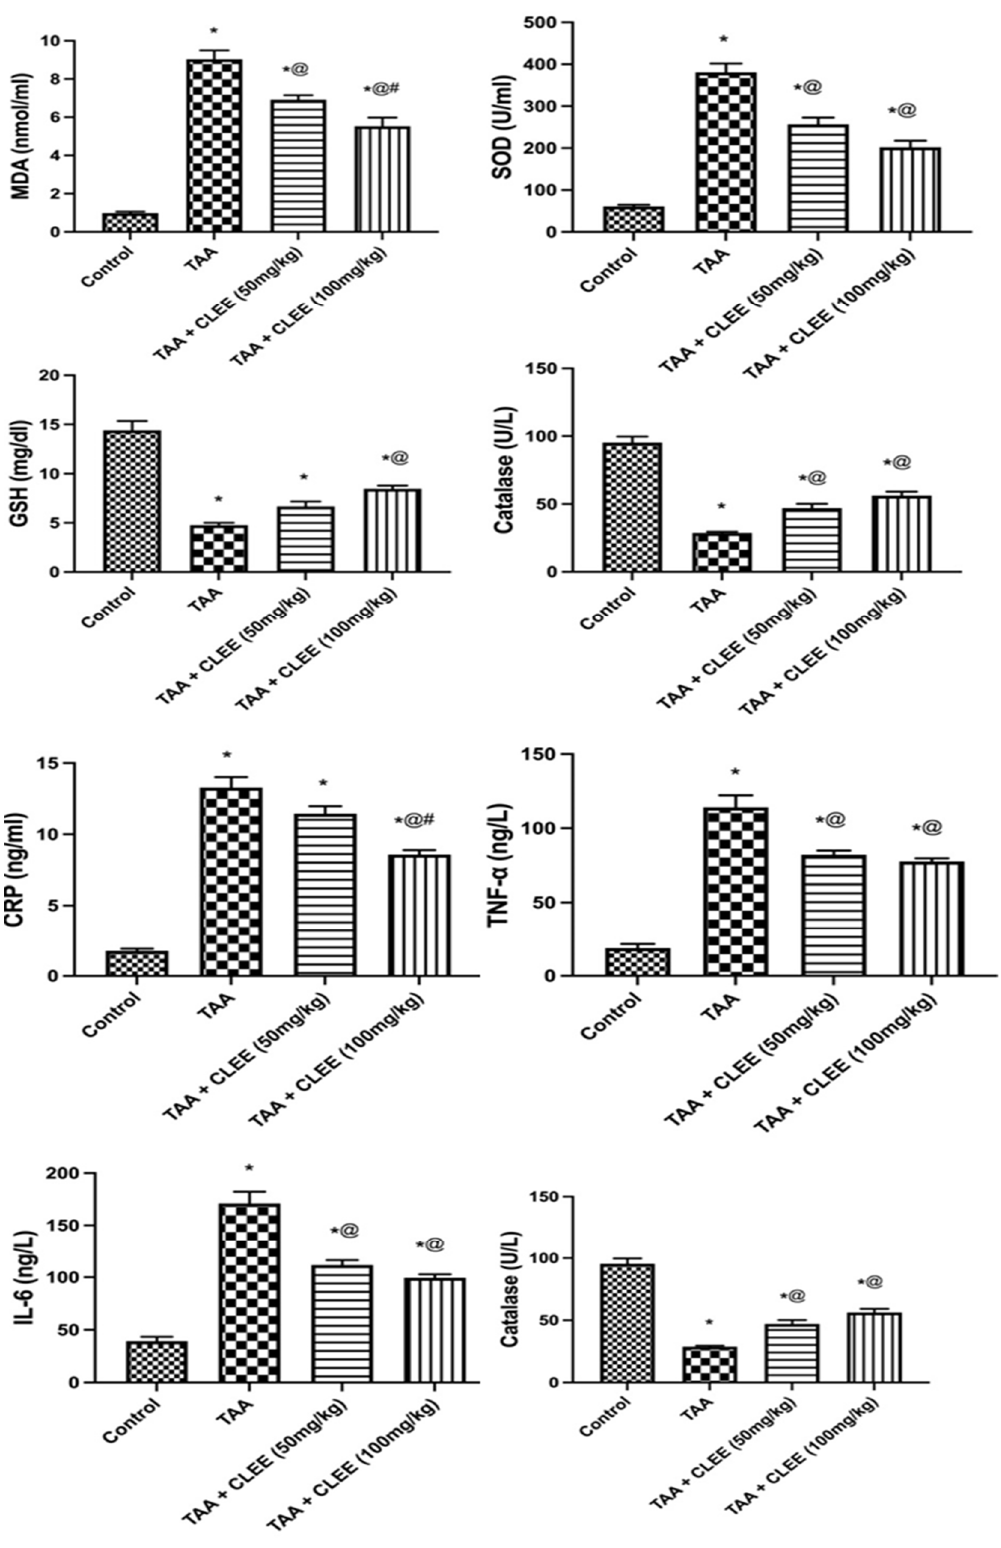
Figure 5. Effect of C. laevigatus EtOH extract (CLEE) on plasma oxidative stress and inflammatory parameters of rats intoxicated by TAA. Each value represents the mean of six animals ± SE. Statistical analysis was performed using one-way ANOVA followed by the Tukey-Kramer multiple comparisons test. (* vs control group, @ vs TAA group and # vs TAA + 50 mg /kg b.w. CLEE group) at p < 0.05.